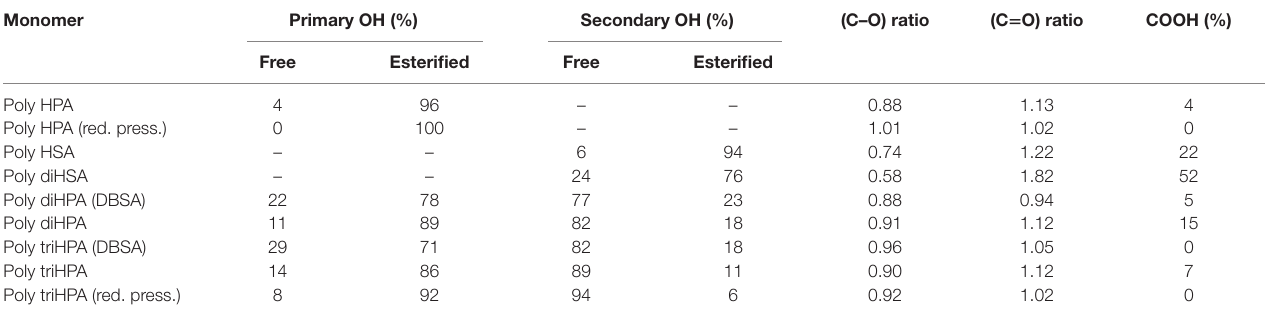
TaBle 1 | chemical composition from 13 c Mas–nMr. Monomer